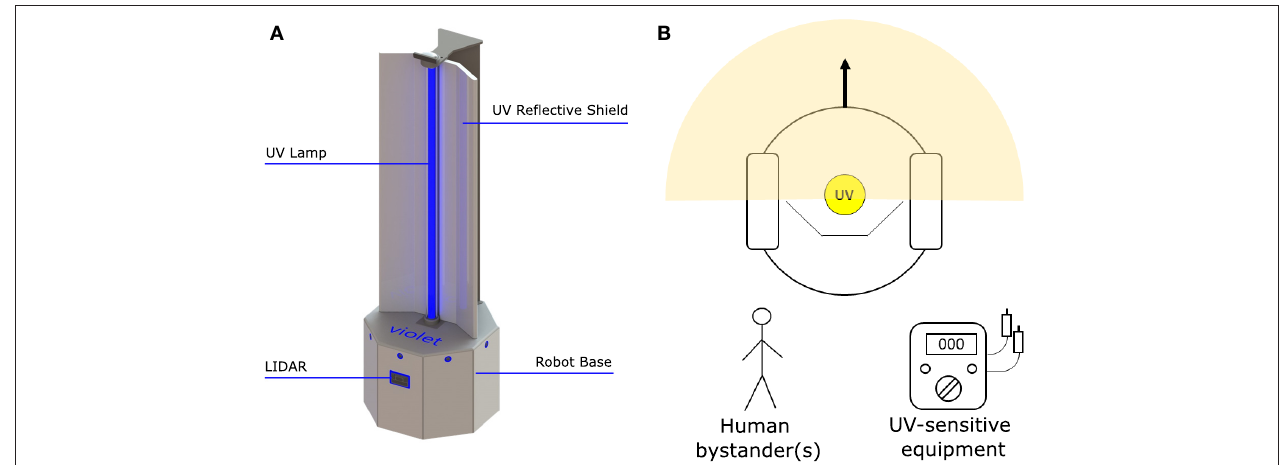
FIGURE 1 | The Violet robot platform. (A) Labeled image illustrating some of the robot’s key features. (B) Plan view illustration of how Violet uses a physical barrier to shield bystanders and/or equipment from irradiation.